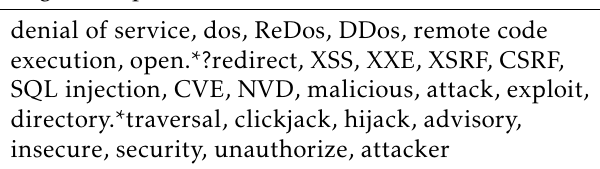
Table 1. The regular expression used to check the candidate negative commits Regular Expression